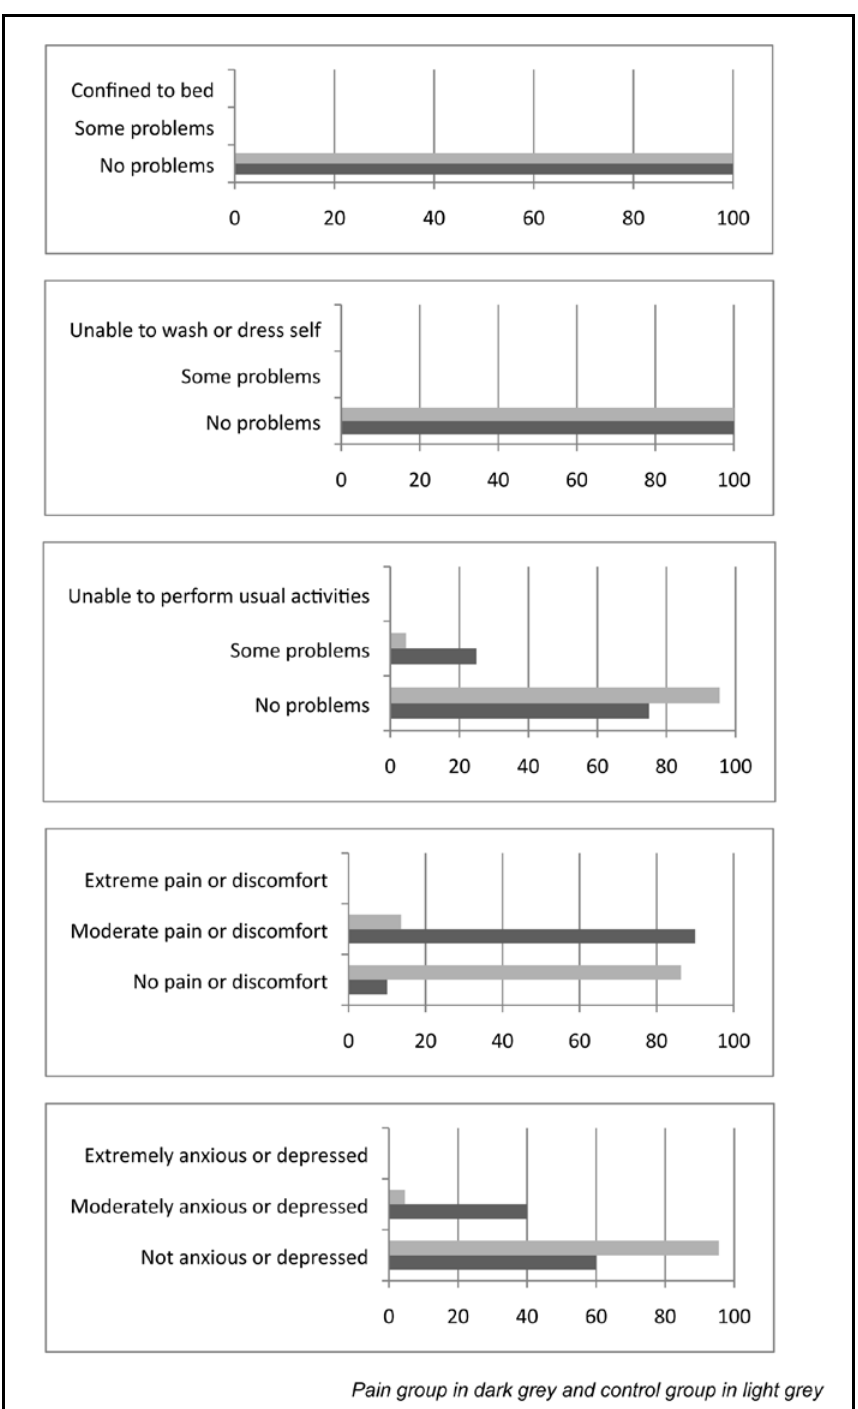
Figure 1: health related quality of life as measured on the eQ-5D (n =